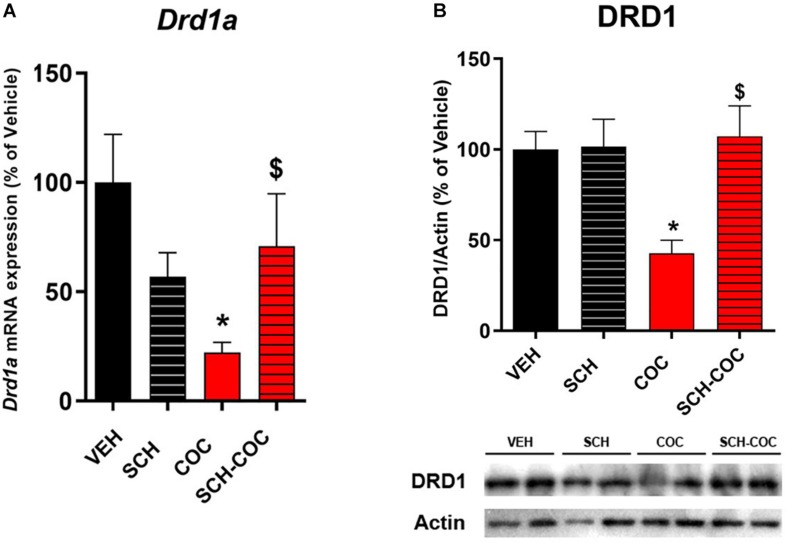
Effect of cocaine (COC), SCH23390 (SCH), and SCH 15 min before COC (SCH-COC) treatments on DRD1 mRNA and protein expression in male germ cells. (A) DRD1 mRNA expression (RT-PCR), Kruskal–Wallis-paired comparisons H = 12.86, p = 0.005. (B) DRD1 protein levels (western blot), ANOVA-Bonferroni F(3,23) = 4.49, p = 0.014. Values indicate mean ± SEM (n = 5–7). *p < 0.05 different from VEH, $p < 0.05 different from COC.